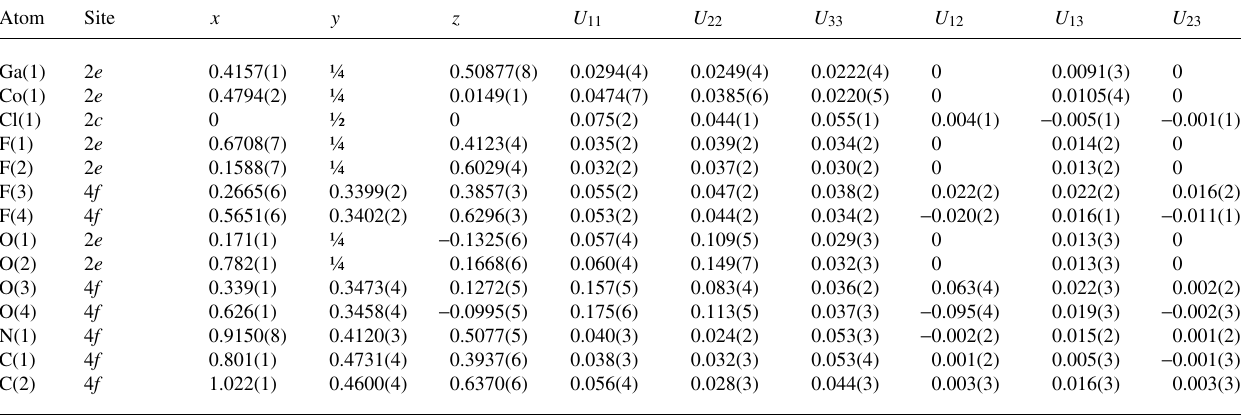
Table 3. Atomic coordinates and displacement parameters (in Å 2 ) .